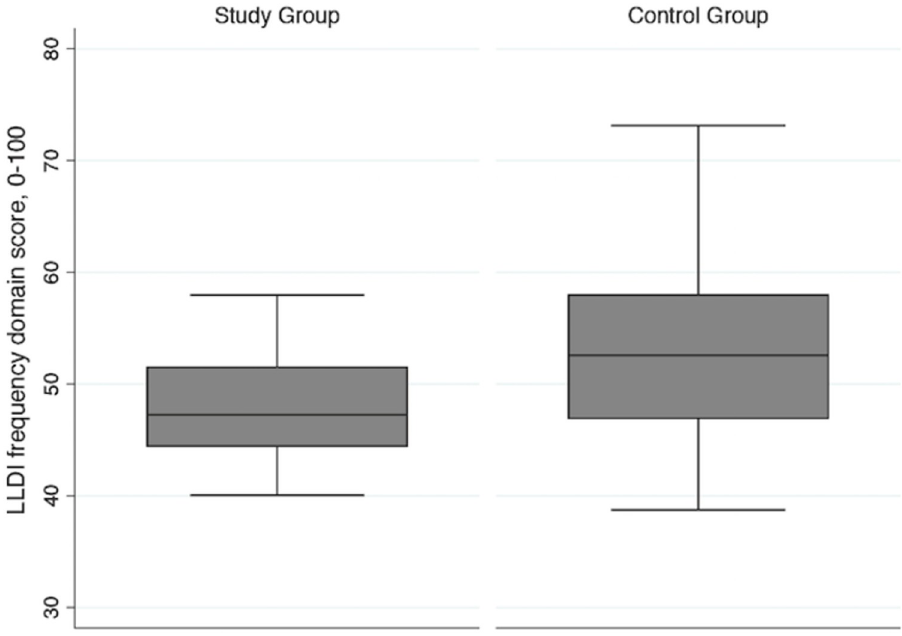
Fig 2. Late-life disability instrument frequency domain scores for the study group and control group. The box represents the 25 th to 75 th percentiles with the horizontal line inside the box representing the median score. The horizontal lines above and below the box represent the maximum (75 th percentile plus 1.5 � IQR) and minimum (25 th percentile minus 1.5 � IQR) scores. IQR = interquartile range.